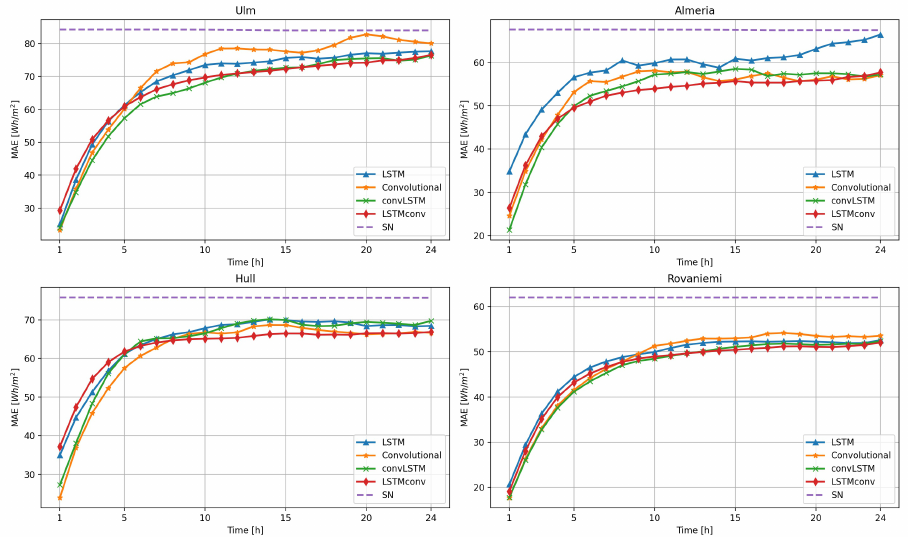
Figure 5. MAE for various neural network models: LSTM, Convolutional, convolutional LSTM (convL- STM), and LSTM convolutional (LSTMconv). As reference the seasonal naive forecast (SN) is shown.